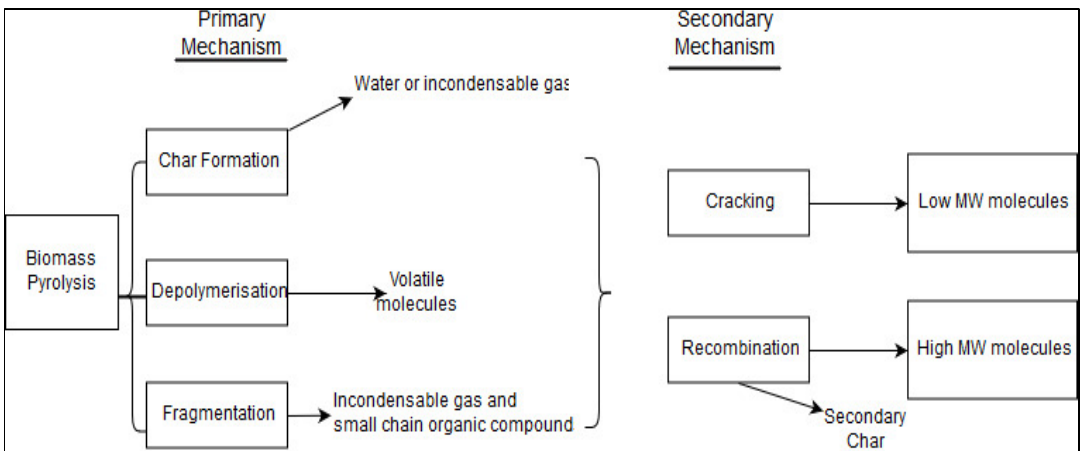
Figure 3. The detailed mechanism of the pyrolysis process.